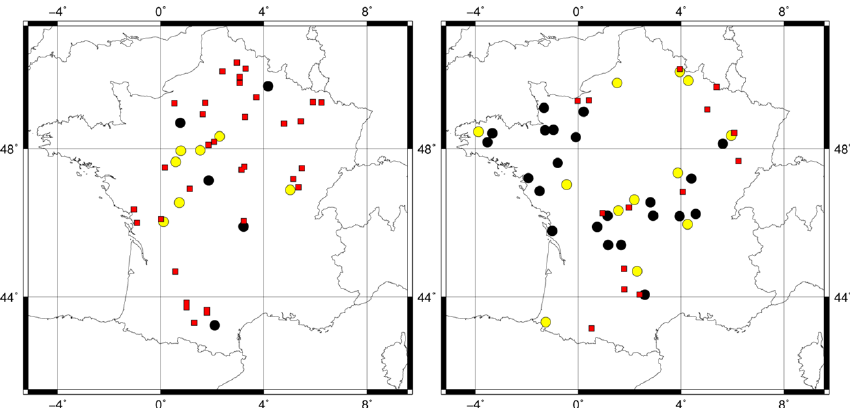
Figure 9. Best FR-2L simulation vs. Agreste statistical correlation levels obtained for (left panel) C3 crops and (right panel) grasslands. Non-significant, significant at the 1% level, and significant at the 0.1% level correlations are indicated in red squares, yellow dots and black dots,